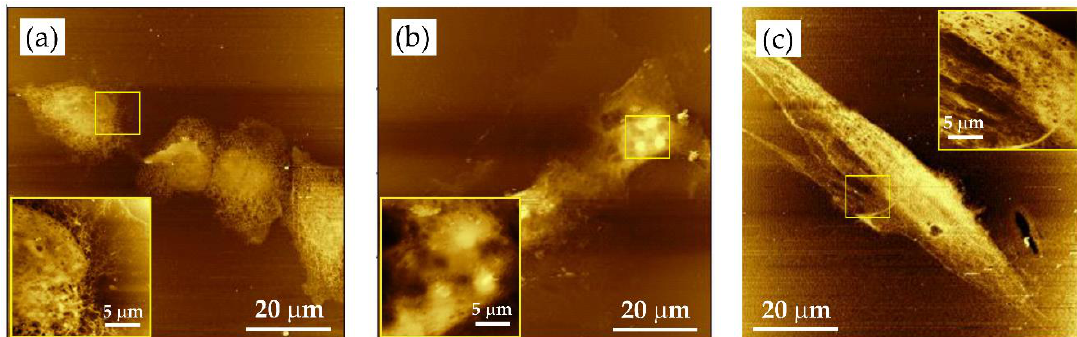
Figure 8. Soft X-ray contact microscopy images of various cell lines: ( a ) DU145, ( b ) HCC38, and ( c ) hMSC. Images obtained with SXR exposure of 800 pulses. Cells fixed with 3.7% paraformaldehyde in phosphate-buffered saline (PBS). Results were collected using AFM (di CPII, Veeco) working in tapping mode. Scan size: 80 × 80 μm 2 . Insets: fragments of cells showing detailed cellular structures (image size 20 × 20 μm 2 ).